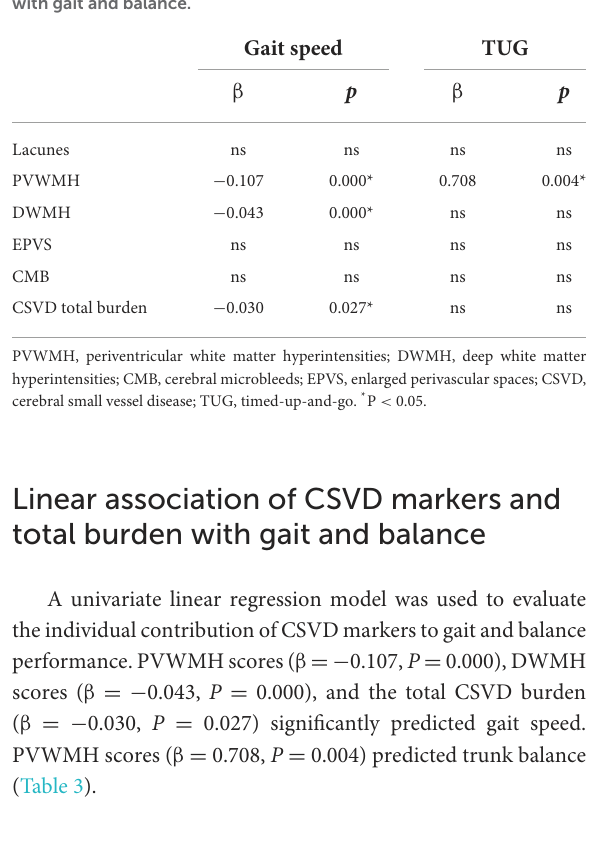
TABLE 2 Correlation analysis of gait and balance function with clinical data.